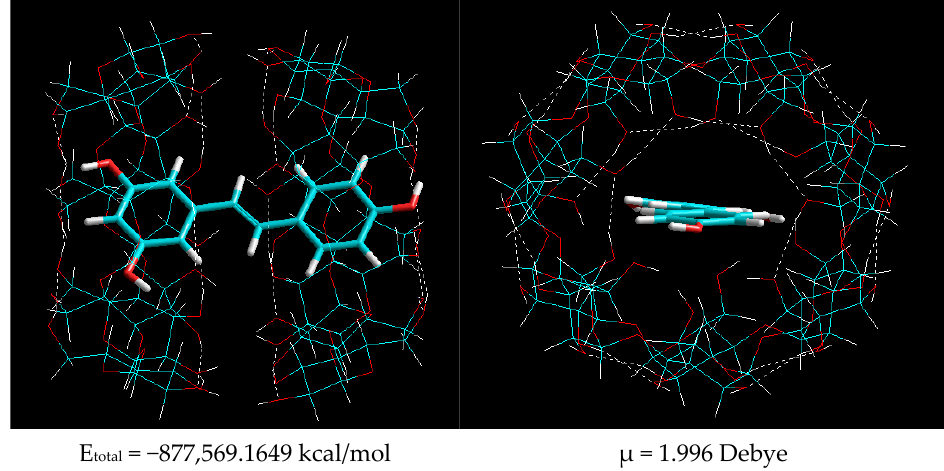
Figure 5. Optimized structure of the type II β -CD – resveratrol complex at a 2:1 ratio.